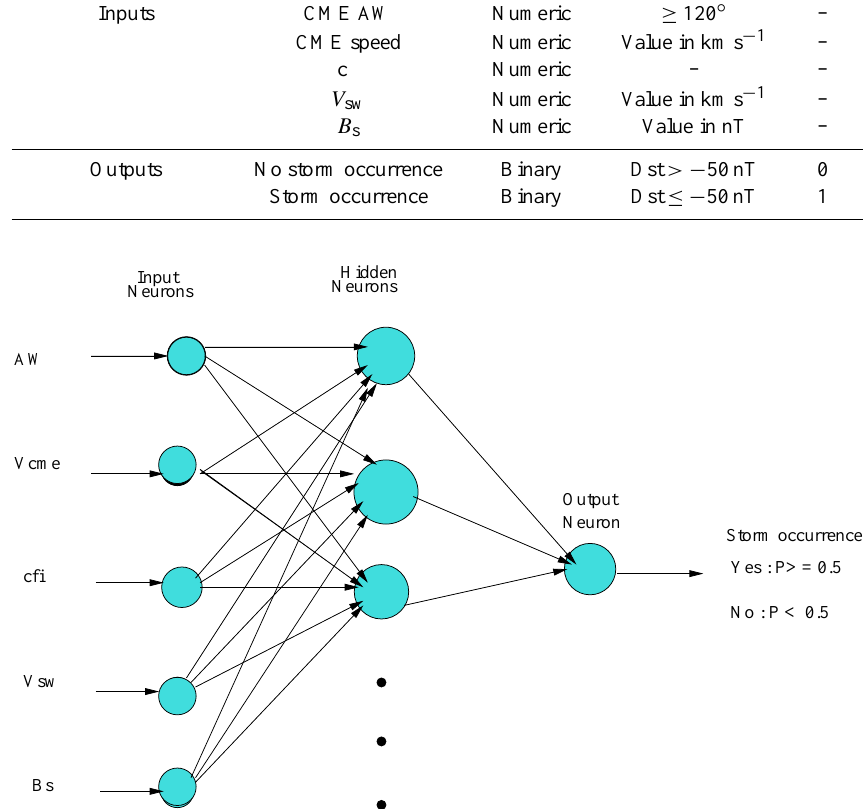
Fig. 2. A simplified illustration of the three-layered FFNN architecture as developed and used in this study. For simplicity, in this analysis we followed the classifica- tion by Gopalswamy et al. (2007) to categorize two kinds of of the model’s ability to predict the output in a general way. 356 events: moderate storms ( − 100 nT < Dst ≤ − 50 nT) and in- tense storms Dst ≤ − 100 nT. As shown in Table 1, the storm occurrence (a row of NN outputs before training) is repre- sented by binary values: 1 in the case of a moderate to intense storm occurrence (Dst ≤ − 50 nT) and 0 in the presence of a minor (or absence of a) storm (Dst > − 50 nT). GMS events are defined here as storms periods with Dst ≤ − 50 nT, which may last from a few hours to a couple of